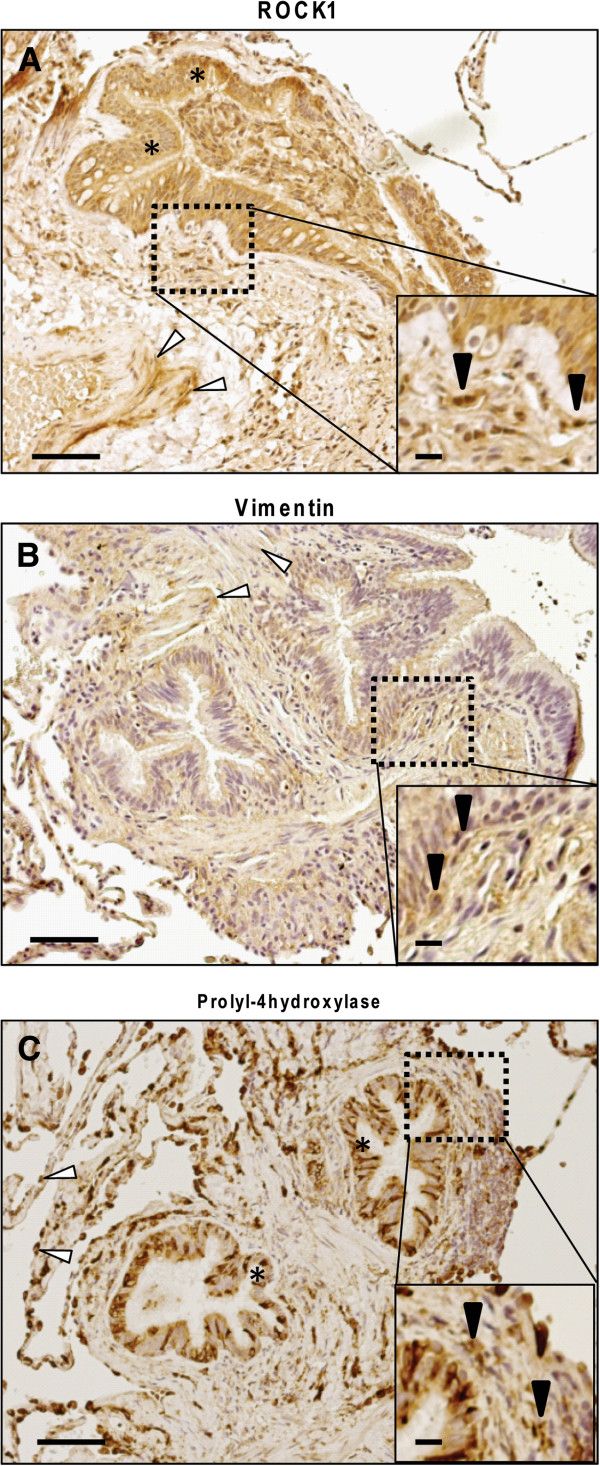
Fibroblast and ROCK1 staining in lung sections from COPD patients. Representative micrograph from one COPD patient that show immunostaining with antibodies against ROCK1, vimentin and prolyl-4 hydroxylase. Antibodies were visualized by DAB (shown in brown) and sections were counterstained with Mayer’s hematoxylin, which stains cell nuclei blue. (A) showsROCK1 staining. Asterisks indicate the bronchiolar epithelium. Smooth muscle cells are indicated by open arrowheads. (B) shows vimentin staining. Open arrowhead show smooth muscle cells. (C) shows prolyl-4 hydroxylase staining. Asterisks show immuno-positive bronchiolar epithelial cells. Alveolar type II cells are indicated by open arrowheads. Inserts show subepithelial, elongated, spindle-like immuno-positive cells (indicated by closed arrowheads). Scale bars represent 50 μm of the larger image and 10 μm on inserts.